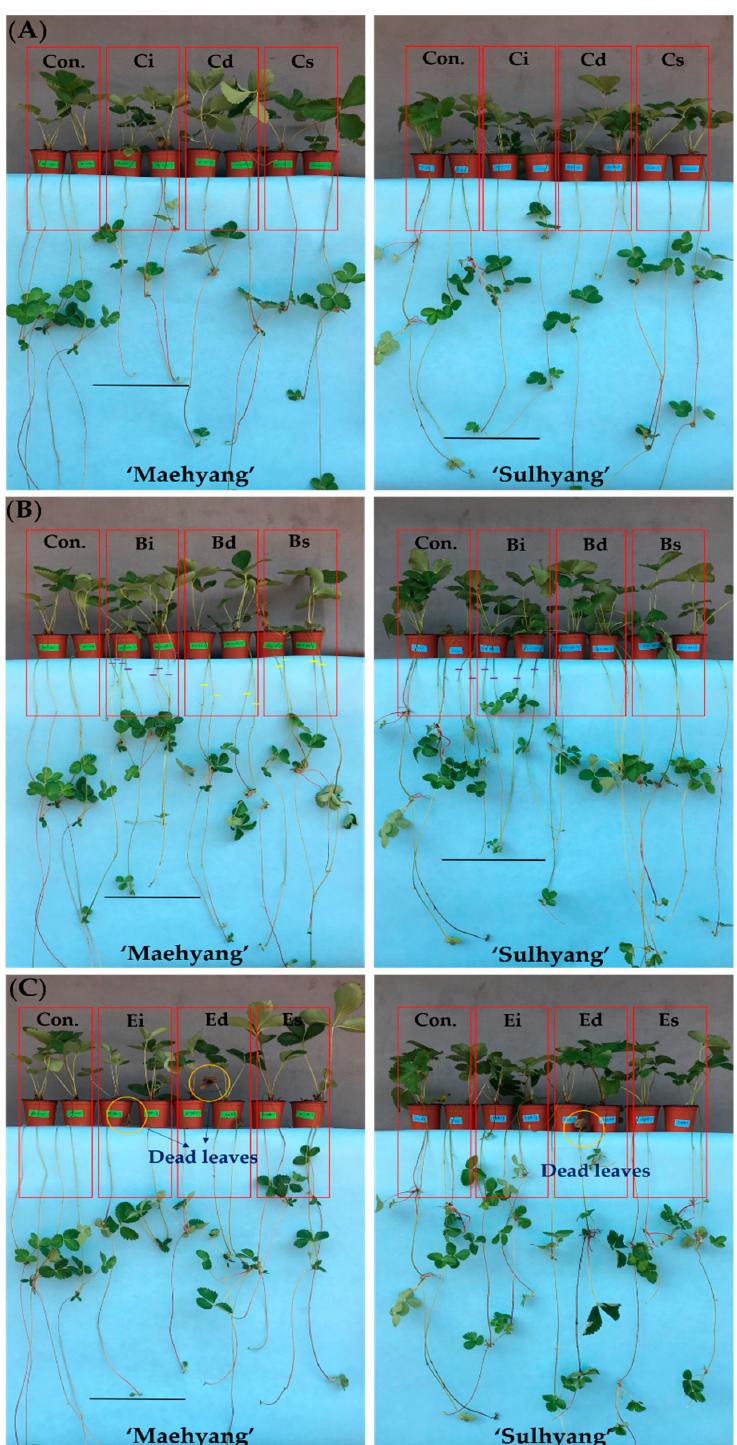
Figure 1. The effects of ( A ) chlormequat chloride (CCC), ( B ) 6-benzylaminopurine (BA), and ( C ) ethephon (ETH) at a concentration of 100 mg·L − 1 and the application method (injection, drench, and spray) on the number and length of runners of strawberries ‘Maehyang’ and ‘Sulhyang’ observed 30 days after treatment initiation in strawberries ‘Maehyang’ and ‘Sulhyang’: The letters C, B, and E stand for CCC, BA, and ETH, respectively; I, d, and s stand for injection into crowns, medium drench, and foliar spray, and Con. is the control.